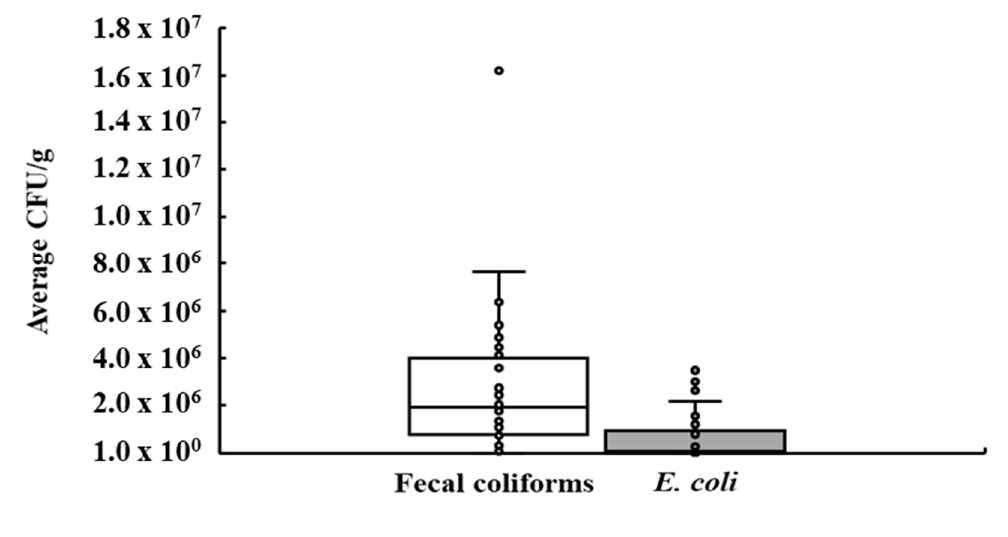
Figure 1. ( a ) The prevalence and loads (colony forming unit (CFU)/g) of fecal coliforms and E. coli in minced beef in Lebanon. The dashed lines show the limit of acceptability based on the Lebanese Standards Institution (LIBNOR) (fecal coliforms; 100 CFU/g), while the black line indicates E. coli limit adopted in other countries (500 CFU/g). NS: indicates no significant difference between the fecal coliforms and E. coli CFU. ( b ) Box and whisker plot showing the variation in the average CFU/g (circles) of E. coli and fecal coliforms in the minced beef samples.